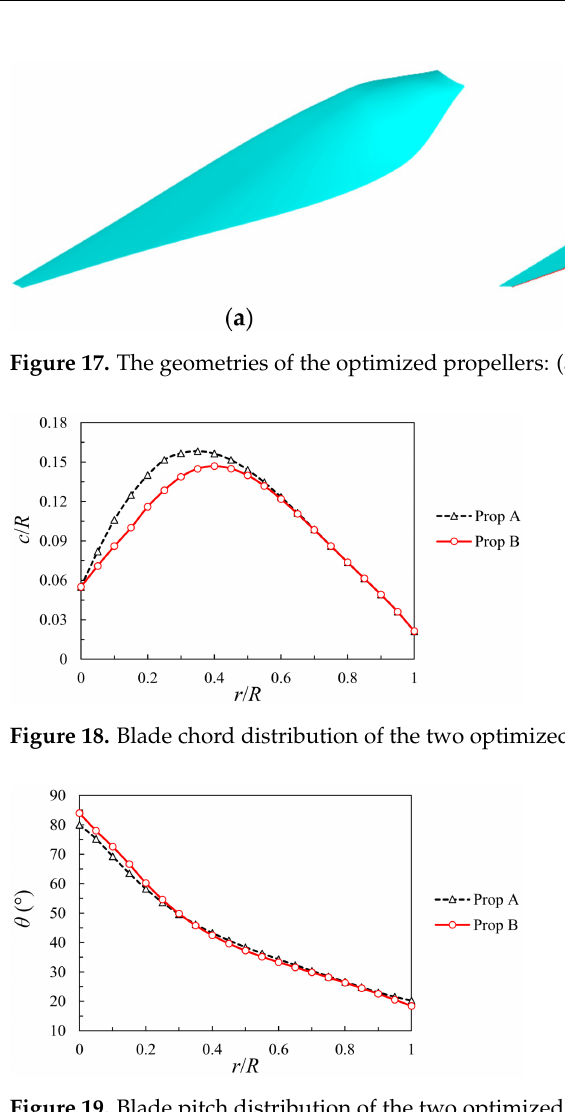
Figure 19. Blade pitch distribution of the two optimized propellers.